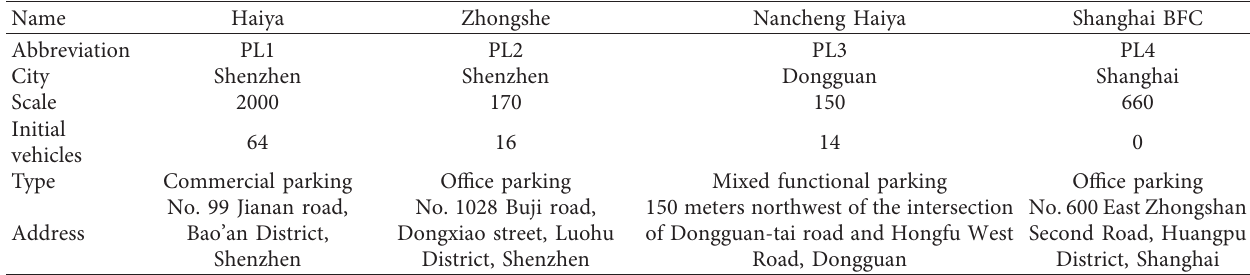
Table 1: Basic information of the four